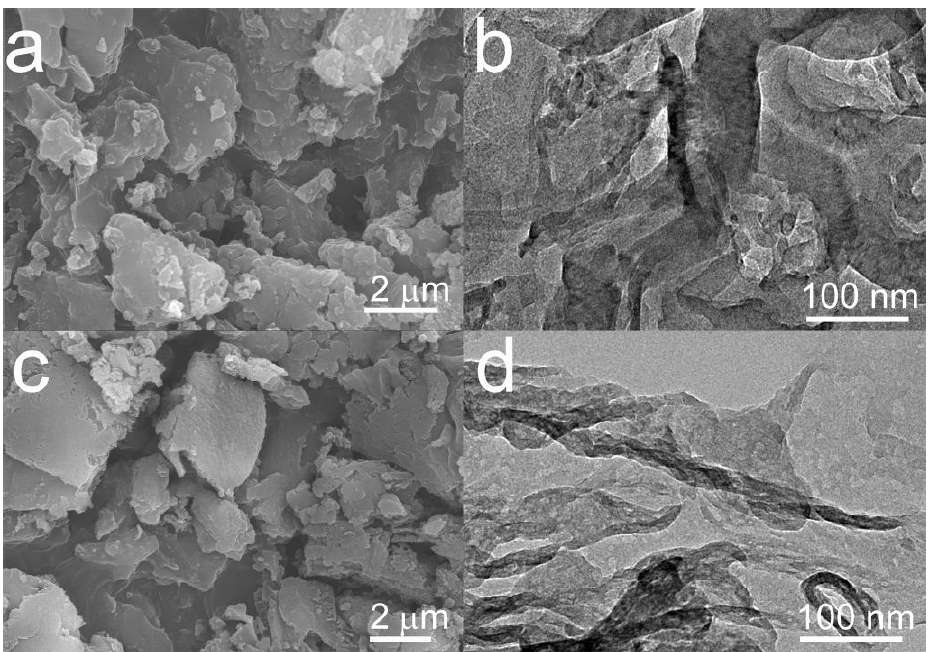
Figure 1. SEM and TEM images of gCN ( a , b ) and gCN-FePc-1 ( c , d ).